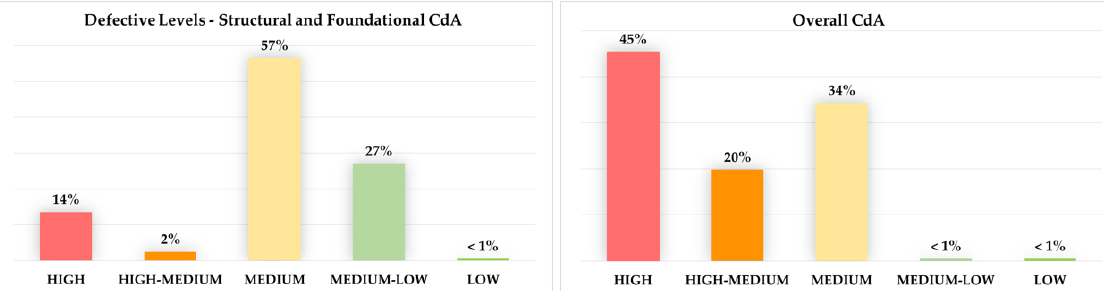
Figure 11. Structural and Foundational CdA and Overall CdA forecast by LG20 approach.